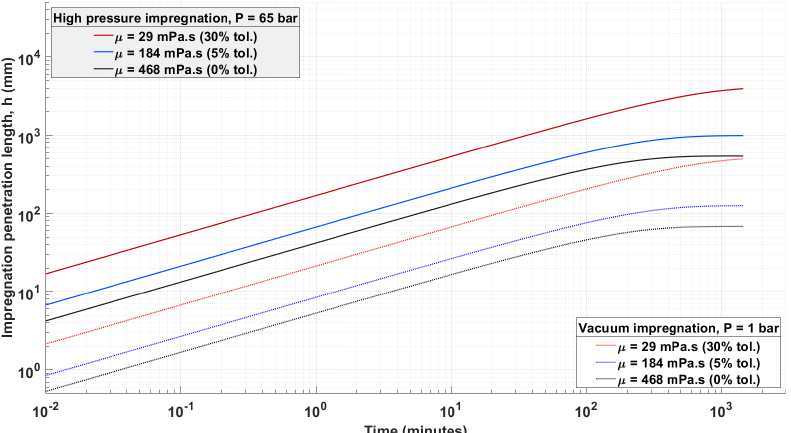
Figure 11. Estimated lengths of impregnation penetration into Indiana limestone versus time. Three resin and toluene (tol.) compositions were tested: (a) pure resin, (b) resin + 5% tol., and (c) resin + 30% tol. Both vacuum and high pressure impregnation schemes were considered for all compositions. The resin penetration length did not change significantly unless the toluene content was more than 30%; however, the mechanical properties for this composition greatly